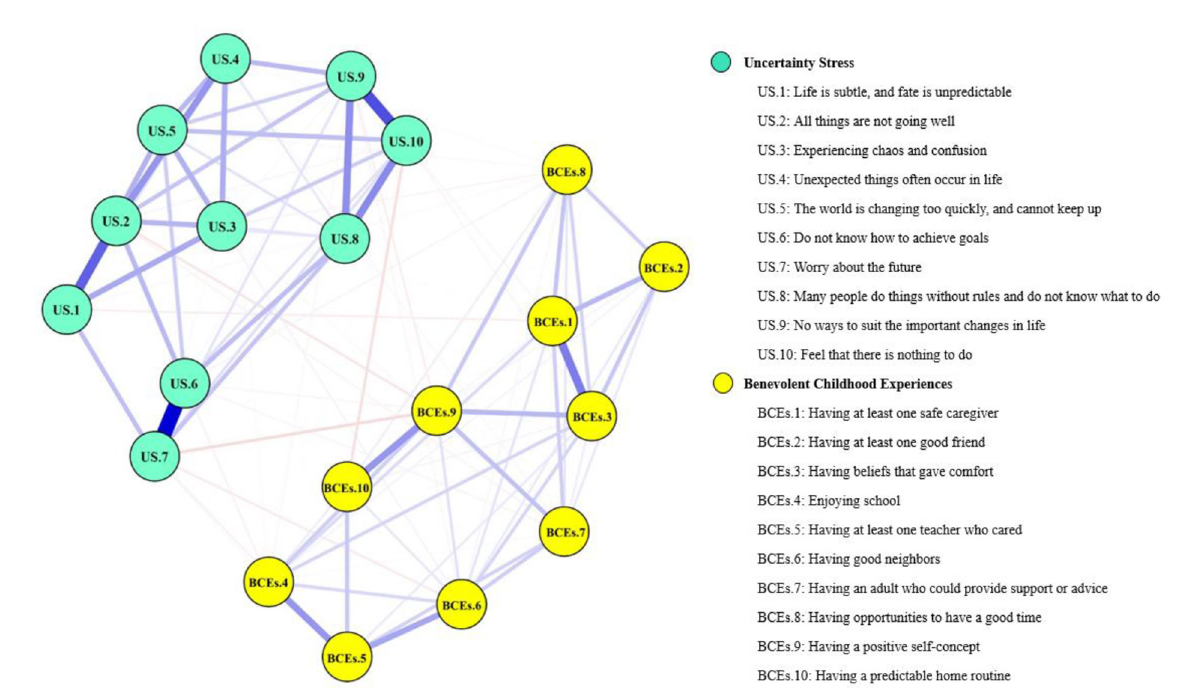
FIGURE1 Network structure of BCEs and uncertainty stress among Chinese university students. The yellow nodes represent the BCEs items while the green nodes denote the uncertainty stress items. The closer the nodes are to each other, the stronger the connection. Meanwhile, blue edges represent positive correlations while red edges represent negative correlations. The magnitude of the correlation between nodes is represented by the edge